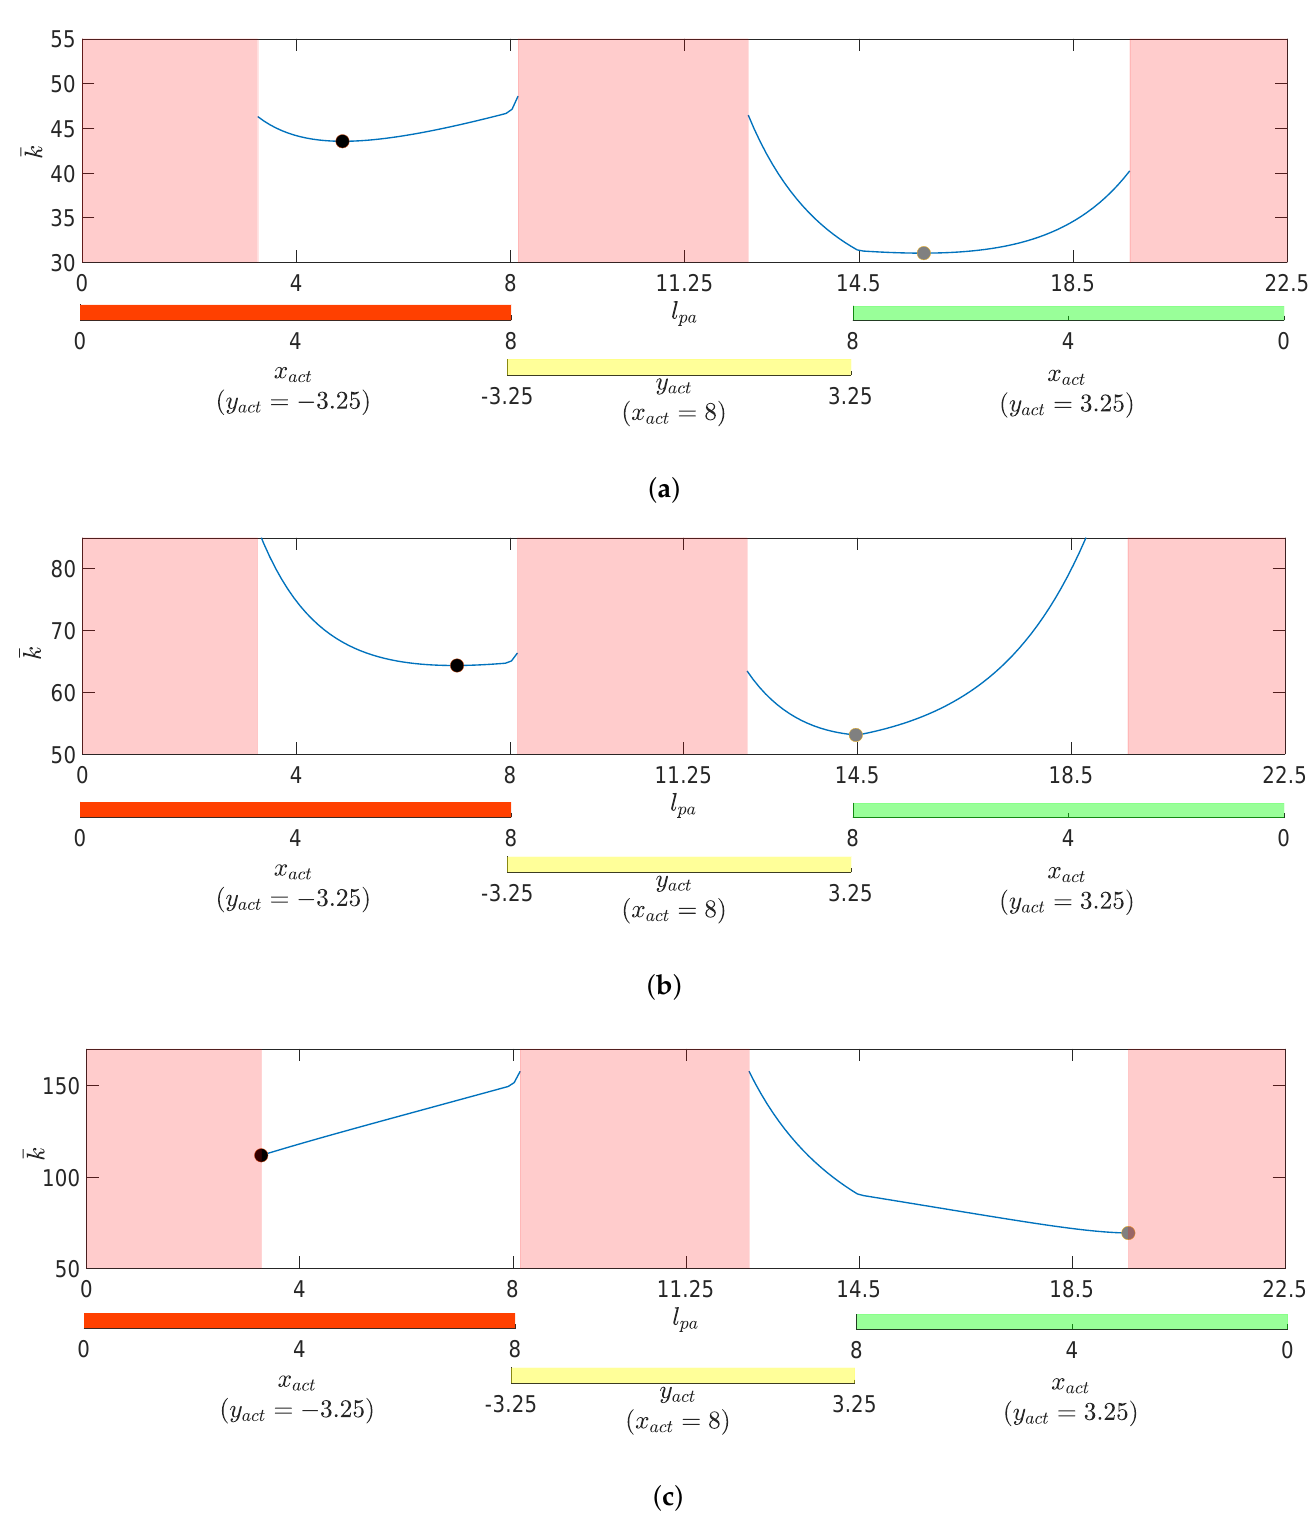
Figure 13. Performance measure cost function as a function of actuator placement, highlighting minimum for both crossed and uncrossed cable configuration. Cables are in crossed configuration when l pa > 11.25 ( a ) κ x = 1, κ y = 1. ( b ) κ x = 4, κ y = 1. ( c ) κ x = 1, κ y = 4.